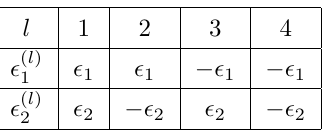
× S 2 (cid:15) 1 (cid:15) 2